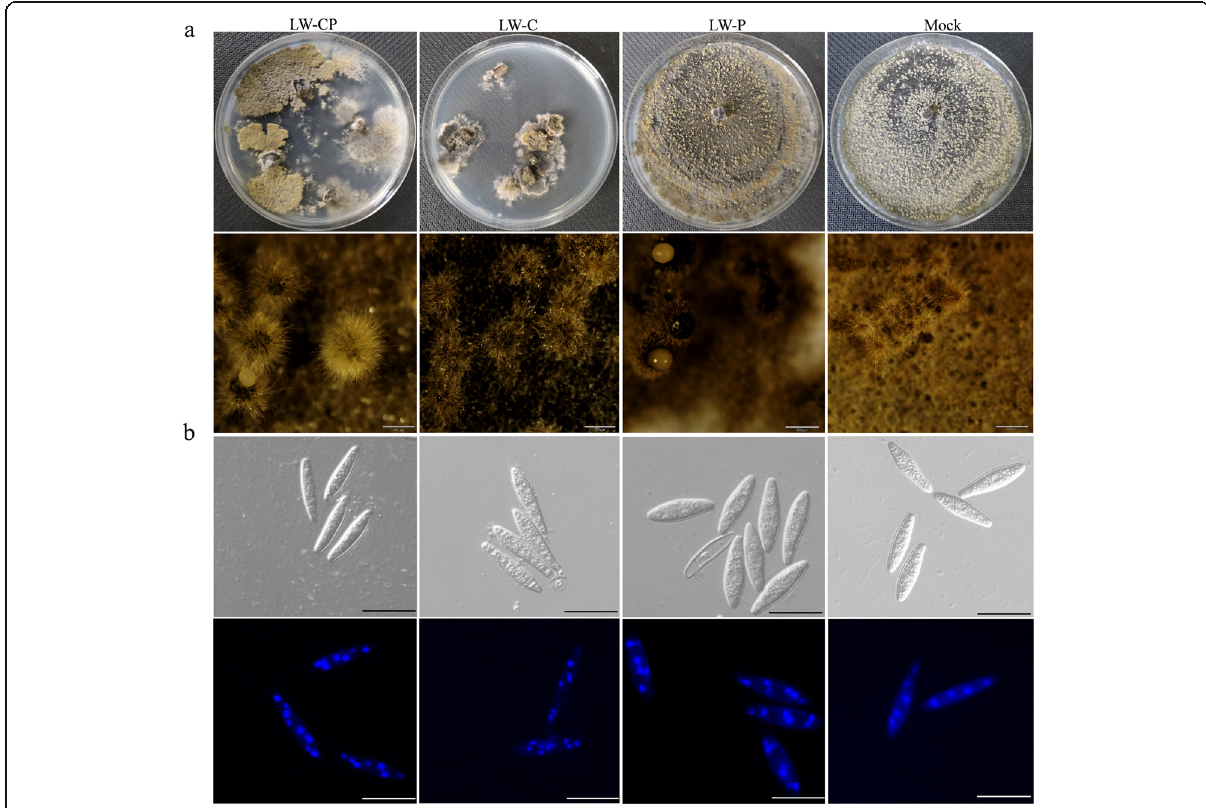
Fig. 1 The conidiomata and conidia phenotype of Botryosphaeria dothidea strains with mycovirus. a Conidiomata and conidial angle of Botryosphaeria dothidea strains (LW-CP, LW-C, LW-P and Mock) on potato dextrose agar (PDA) was observed with the naked eye (upper row) and using stereo microscope (bottom row). Scale bar = 0.5 mm; b The phenotype of conidia of B. dothidea strains cultured on PDA culture observed following DAPI staining. Scale bar = 20 μ